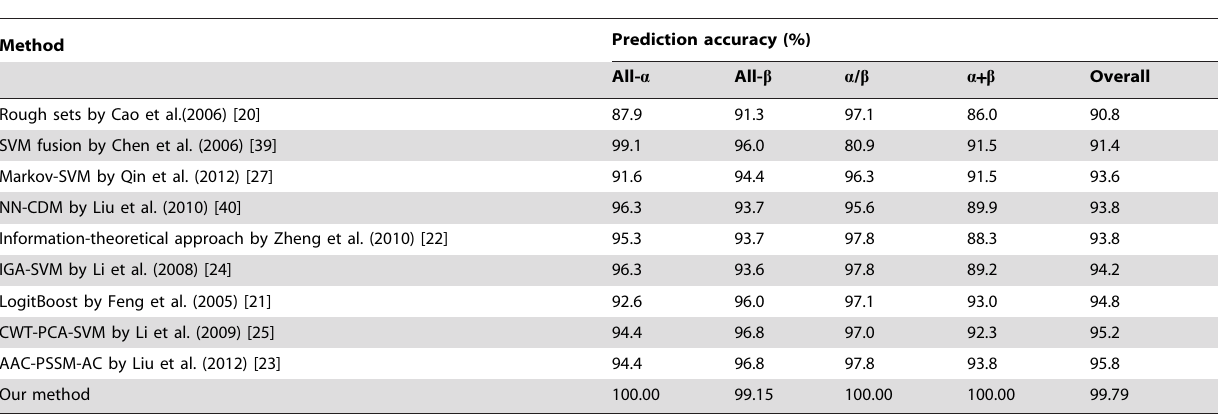
Table 9. Performance comparison of different methods on Z498 dataset.